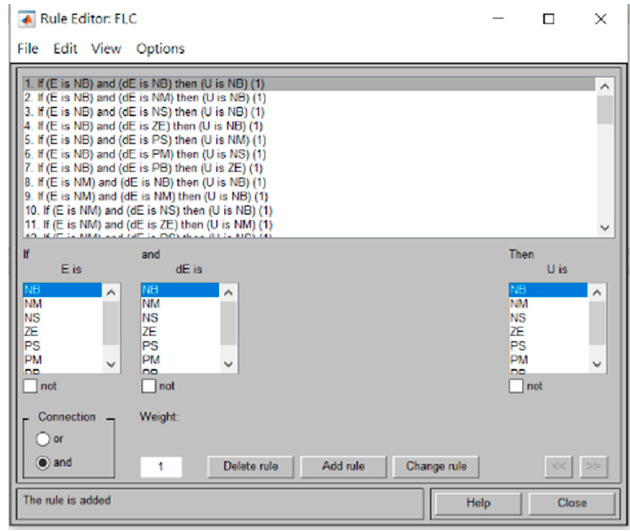
Figure 11. Membership function for output variable “U”. Table 4. Table of membership function for input variable “E”, “ Δ E”, and “U”.